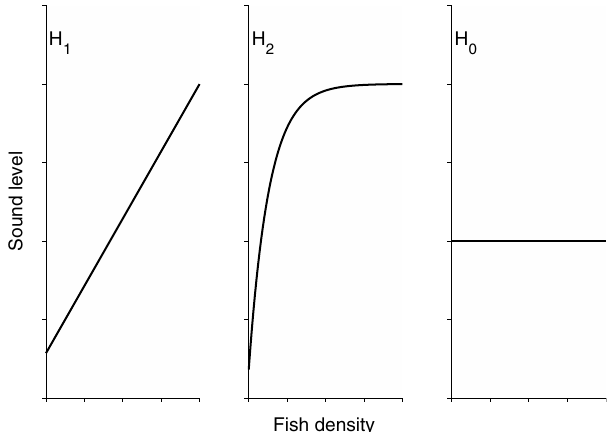
Figure 2. Hypotheses of the relationship between fish sound production levels and density. (H 1 ) A strong, predictive linear relationship with increases in sound levels as a function of density, (H 2 ) a weaker non-linear relationship where sound levels fail to respond to high densities, and (H 0 ) a non-predictive relationship with changes in density not affecting sound